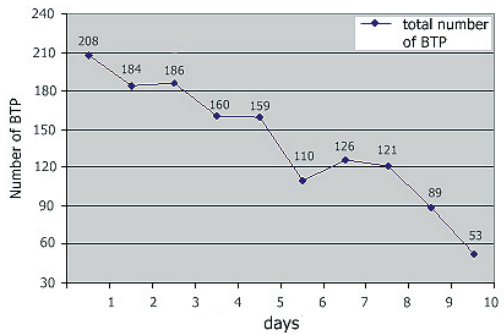
FIGURE 2. The values of blood pressure and pulse depend- ing on BTP